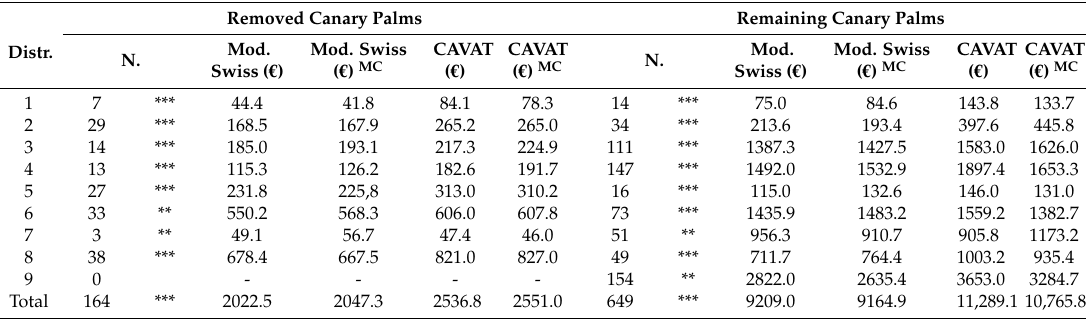
Table 1. Ornamental values in the City of Bari for the removed and the remaining Canary Palms, per district (in thousands of Euros).